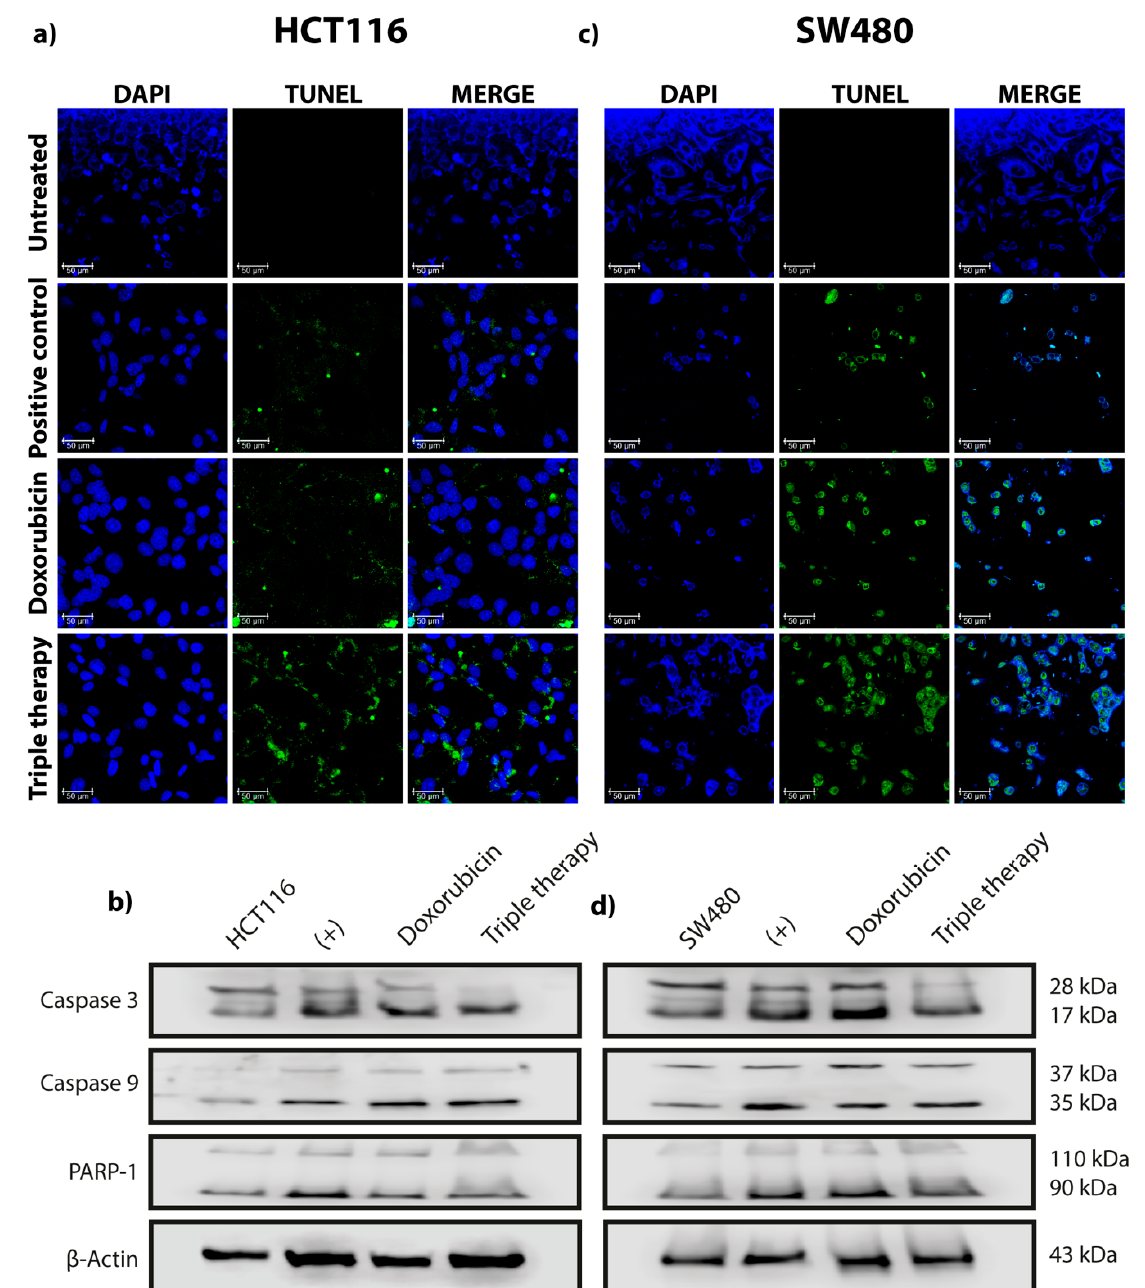
Figure 2. Triple therapy induces cell death by apoptosis in HCT116 and SW480 CRC cells. ( a , c ) TUNEL assay to detect HCT116 and SW480 apoptotic cells treated with doxorubicin and triple therapy for 24 h. Green dots indicate apoptosis in each cell, and the color blue corresponds to DAPI stained for nuclei. Images were obtained by confocal microscopy objective 40 × (Leica TCS-SP8, Wetzlar, Germany); the experiment was done in duplicate. Scale bar of 50 μ m. ( b , d ) Detection of the proteins involved in the apoptosis process by Western blot at 24 h of exposure to doxorubicin and triple therapy in the HCT116 and SW480 cell lines, respectively.